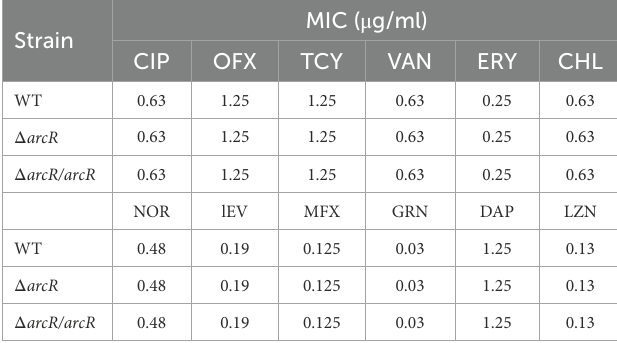
TABLE 3 MICs of S. aureus to